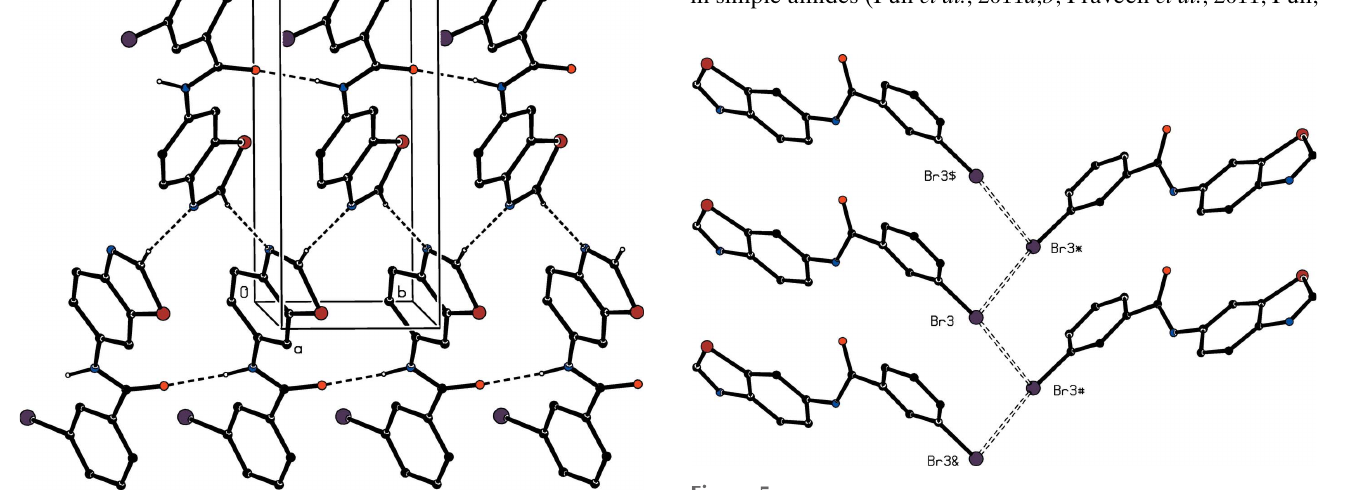
(cid:5) z ), + y , 3 2 2